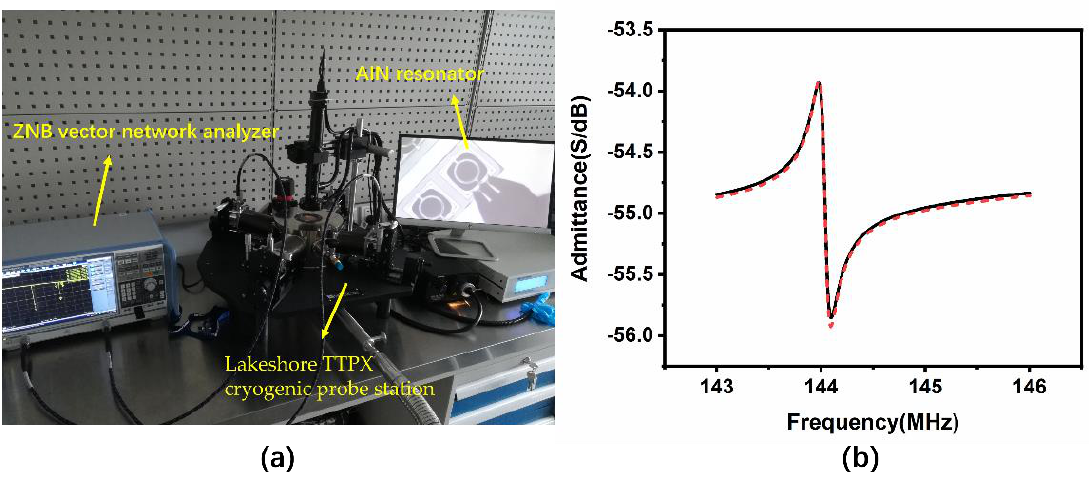
Figure 7. ( a ) ZNB Vector network analyzer and Lakeshore TTPX cryogenic probe station, ( b ) results of the measured admittance versus frequency of the resonator in atmospheric pressure (black line) and low pressure (red dotted line).